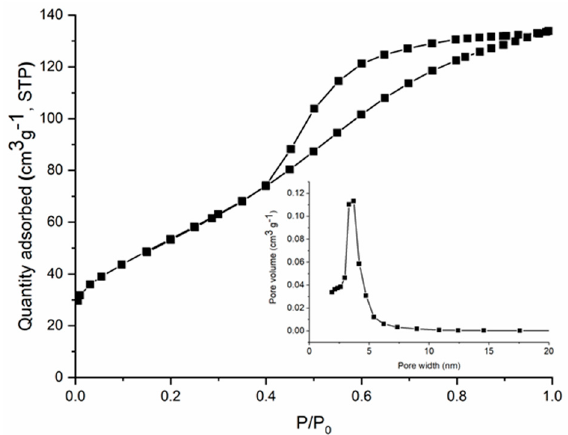
Figure 3. N 2 adsorption − desorption isotherms and pore size distribution (inset) of CoFe 2 O 4. The X-ray diffractograms of the prepared magnetic materials and free chitosan are presented in Figure 4.